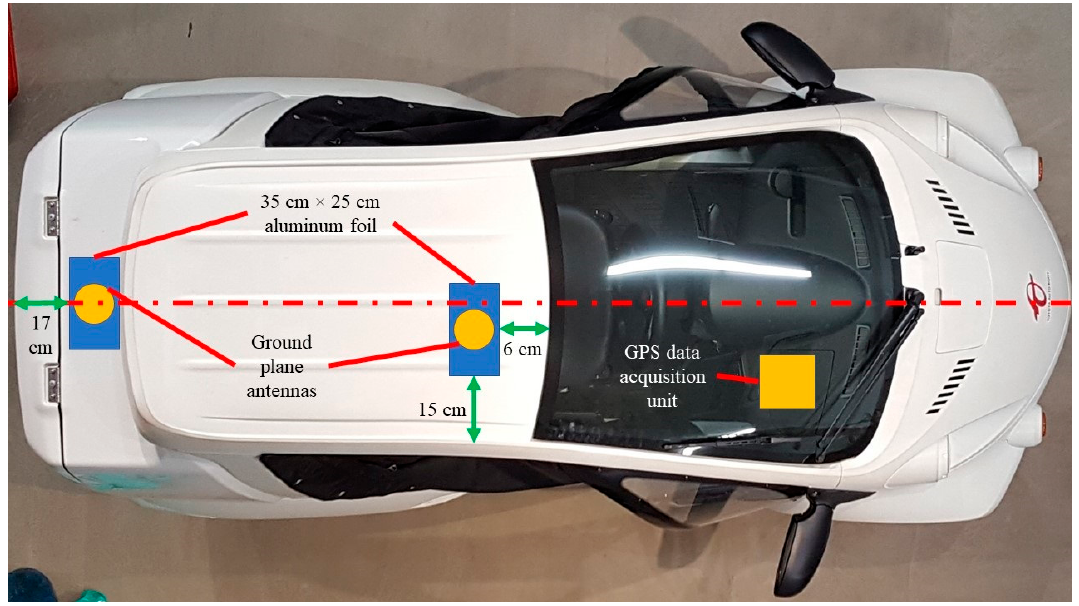
Figure 5. Setup of antennas for GPS data logging system mounted in cabin of COMS vehicle.